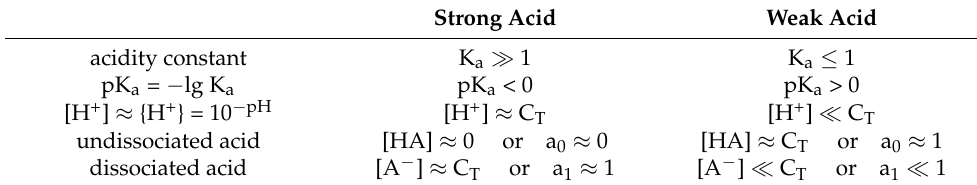
Table 5. Strong vs. weak acids (greatly simplified).